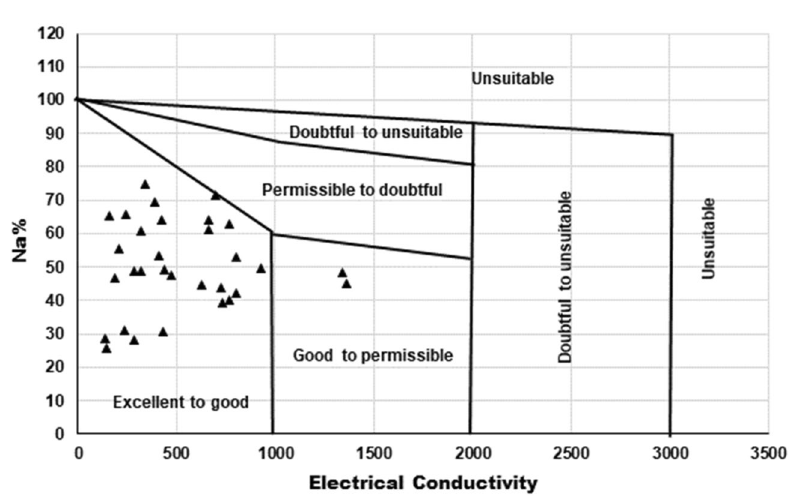
Figure 17. Surface water rating using Sodium Percentage and Electrical